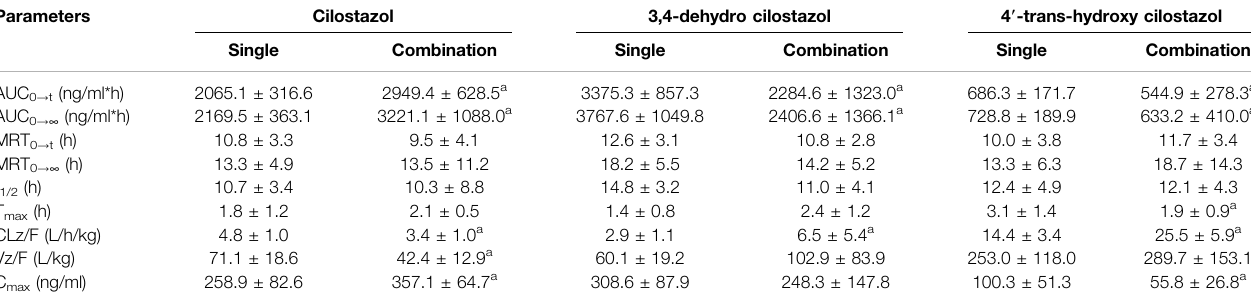
TABLE 6 | The main pharmacokinetic parameters of cilostazol and its metabolites with or without baicalein in rat plasma. ( n = 6, Mean ± SD).